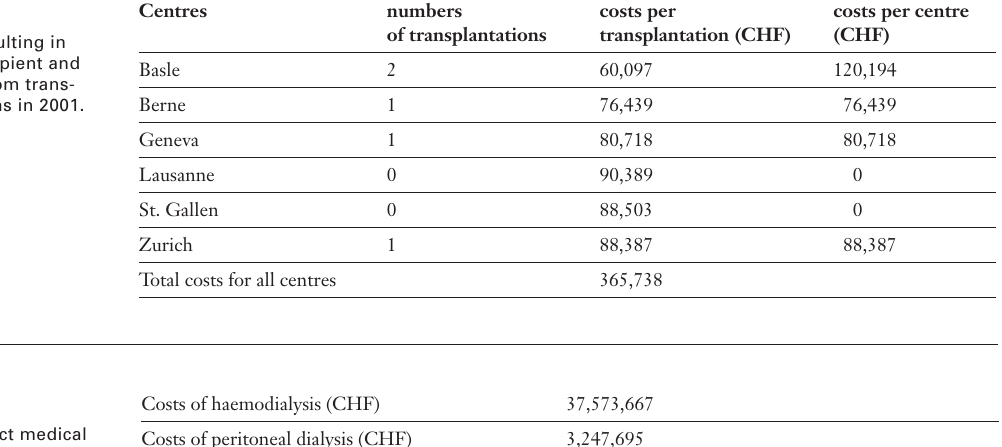
Total direct medical costs of ESRD in pa- tients with type 2 DM in Switzerland in 2001 (total and sub- divided according to type of therapy).